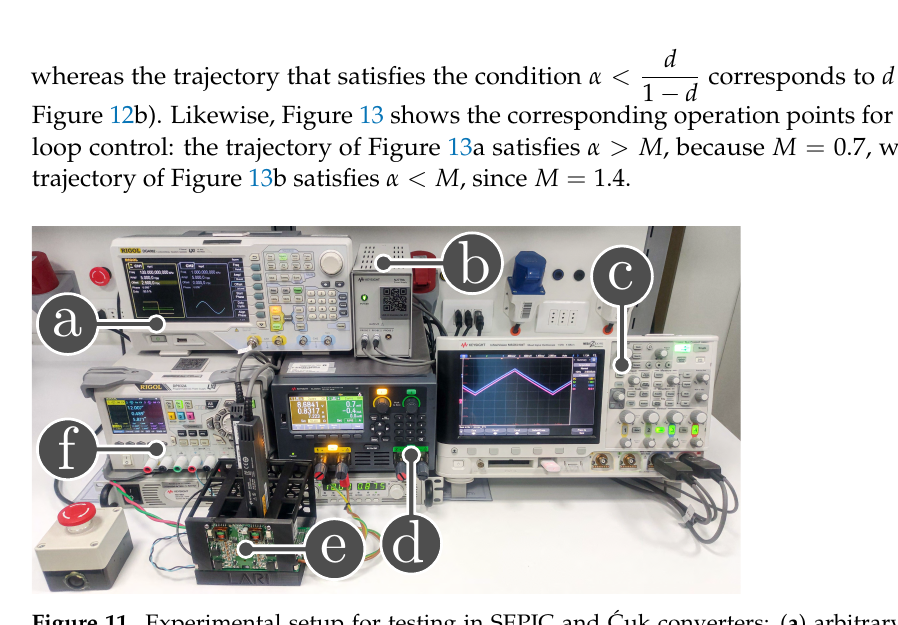
Figure 11. Experimental setup for testing in SEPIC and ´Cuk converters: ( a ) arbitrary waveform generator to program the duty cycles, ( b ) auxiliary power supply to current probes, ( c ) oscilloscope, ( d ) electronic load, ( e ) reconfigurable prototype, and ( f ) DC power source.